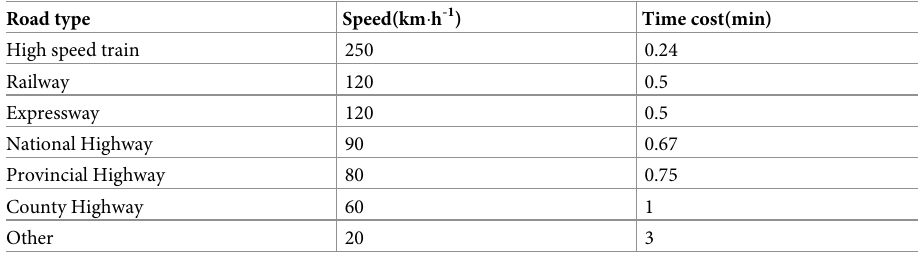
Table 1. Velocity and cost of the cantonal land traffic